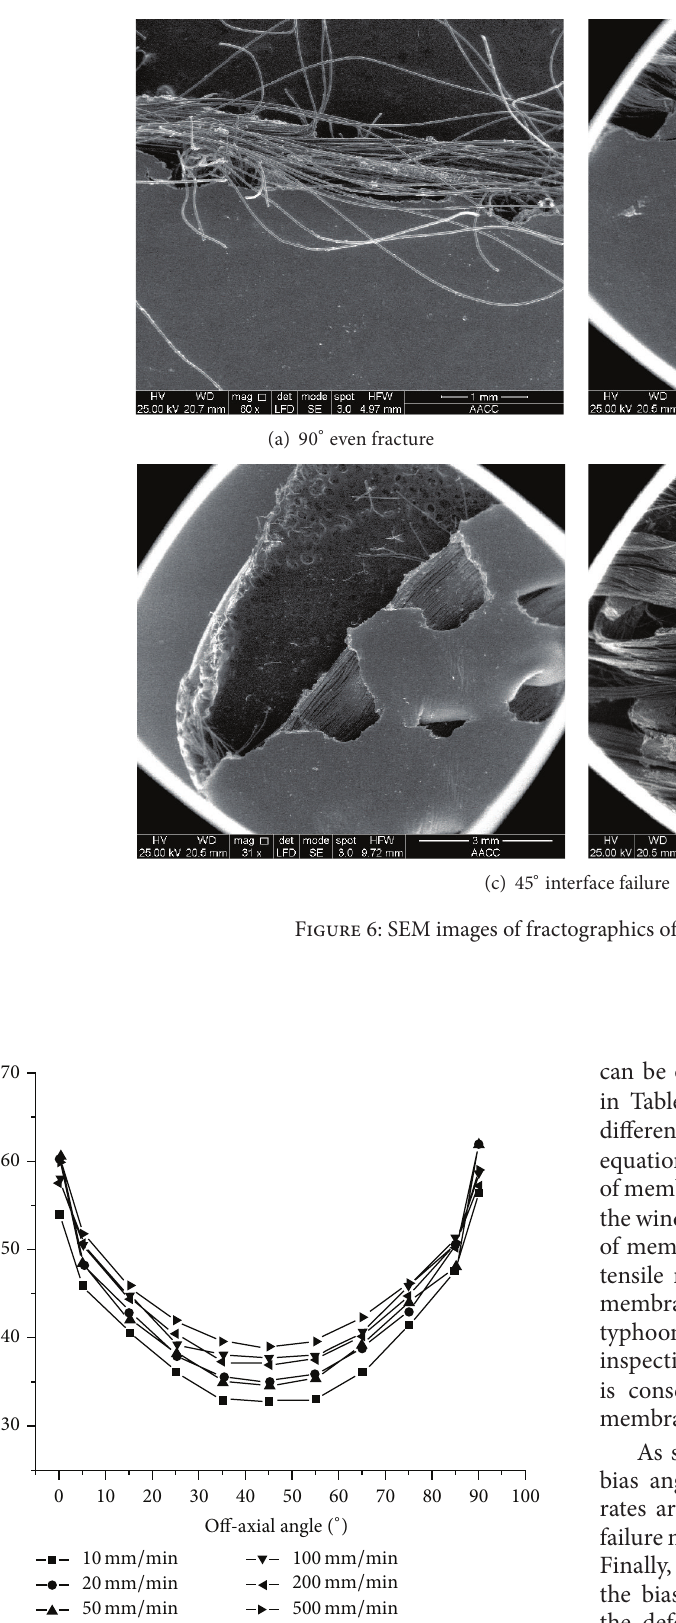
Figure 7: Off-axial tensile strength of Precontraint 702 T2 under different loading